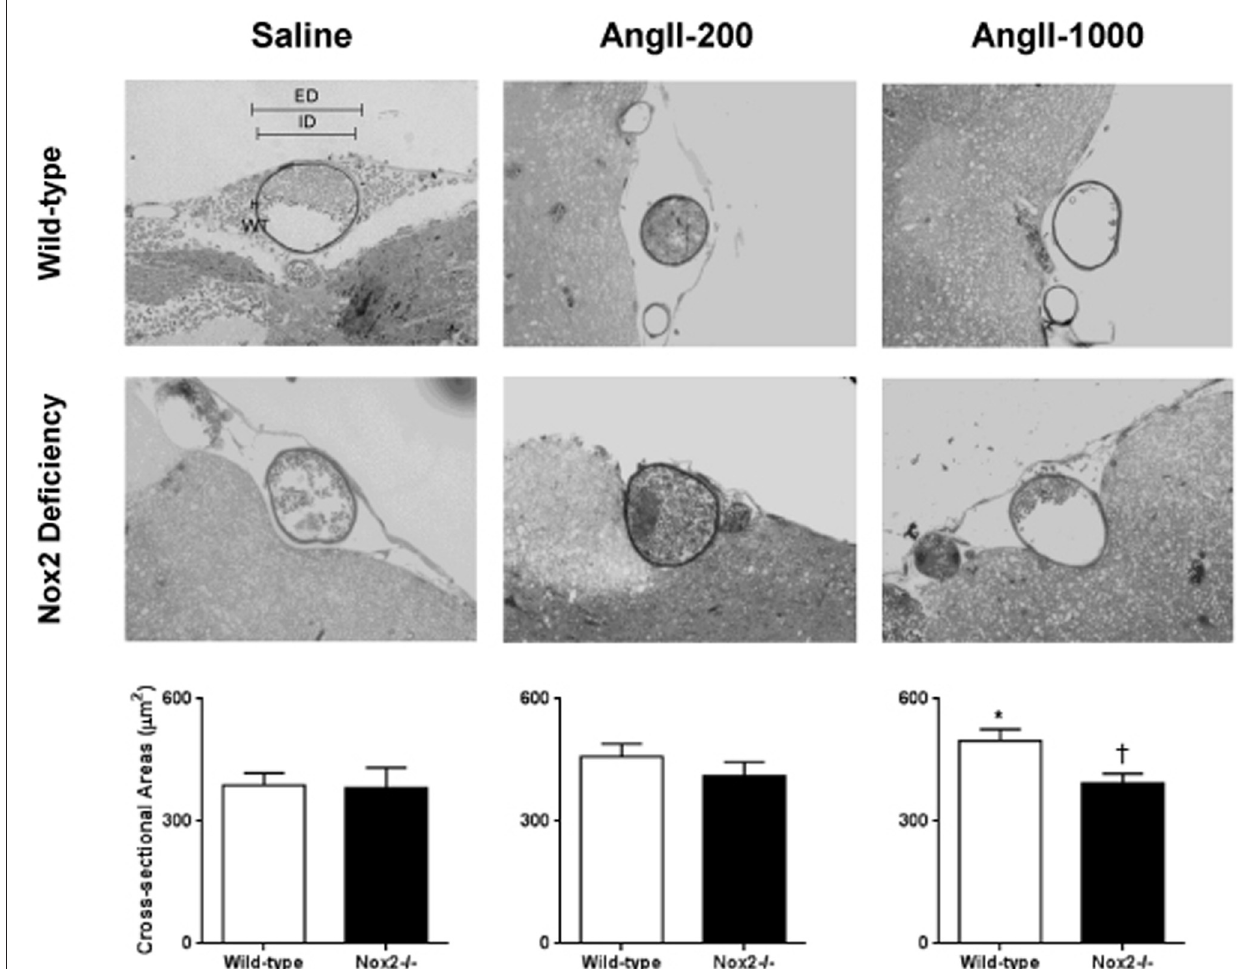
FIGURE 3 | Representative micrographs of histological sections and cross-sectional area (CSA) of maximally dilated cerebral arterioles in wild-type (WT) and Nox2-deficient ( − / − ) mice treated with a pressor (AngII-1000) or a non-pressor (AngII-200) dose of